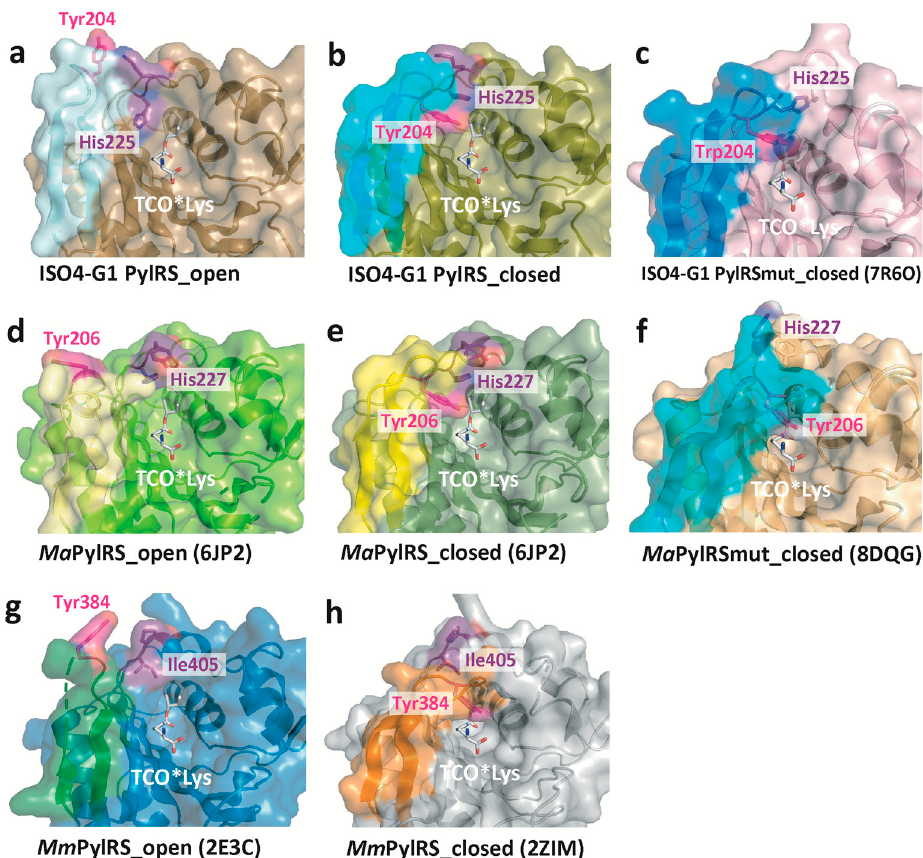
Figure 4. Open and closed conformations of the β 5- β 6 (ISO4-G1 PylRSs), β 5- β 6 ( M. alvus PylRSs), and β 7- β 8 ( M. mazei PylRScs) hairpins. Translucent surface models of the active-site pockets in the ISO4-G1 PylRS apo form (brown, a ; gold, b ), the ISO4-G1 PylRS mutant for cyanopyridylalanine in the apo form (light pink, c ) (PDB: 7R6O), the Ma PylRS apo form (yellow green, d ; grass green, e ) (PDB: 6JP2), the acrydonylalanine and AMPPNP-bound Ma PylRS mutant (light orange, f ) (PDB: 8DQG), the M. mazei PylRSc apo form (blue, g ) (PDB: 2E3C), and the Pyl-AMP-bound Mm PylRSc (gray, h ) (PDB: 2ZIM) are shown. The β 5- β 6 (ISO4-G1 PylRSs), β 5- β 6 ( M. alvus PylRSs), and β 7- β 8 ( M. mazei PylRScs) hairpins are colored differently. Tyr204, Tyr206, and Tyr384 are highlighted in magenta. The bound TCO*Lys in the PylRS active site is shown as a stick model (PDB: AAO).